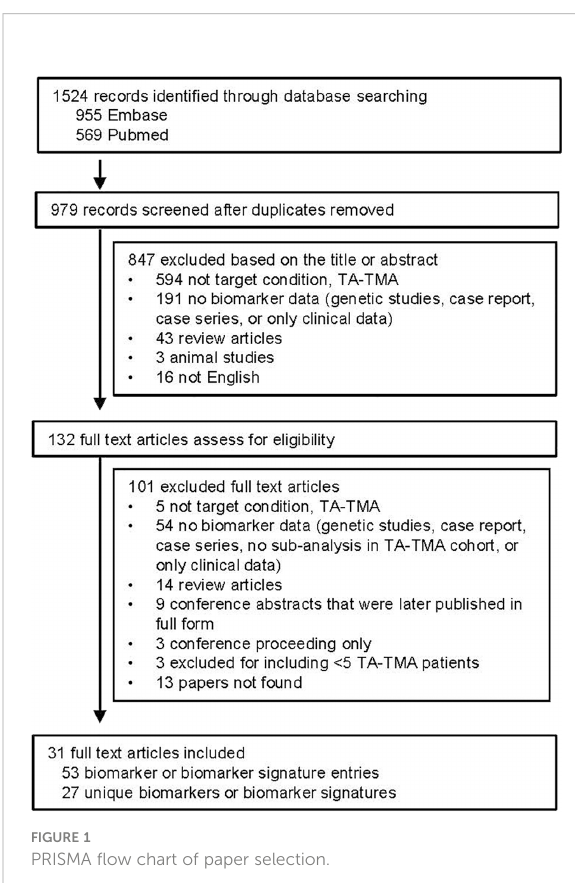
FIGURE 1 PRISMA fl ow chart of paper